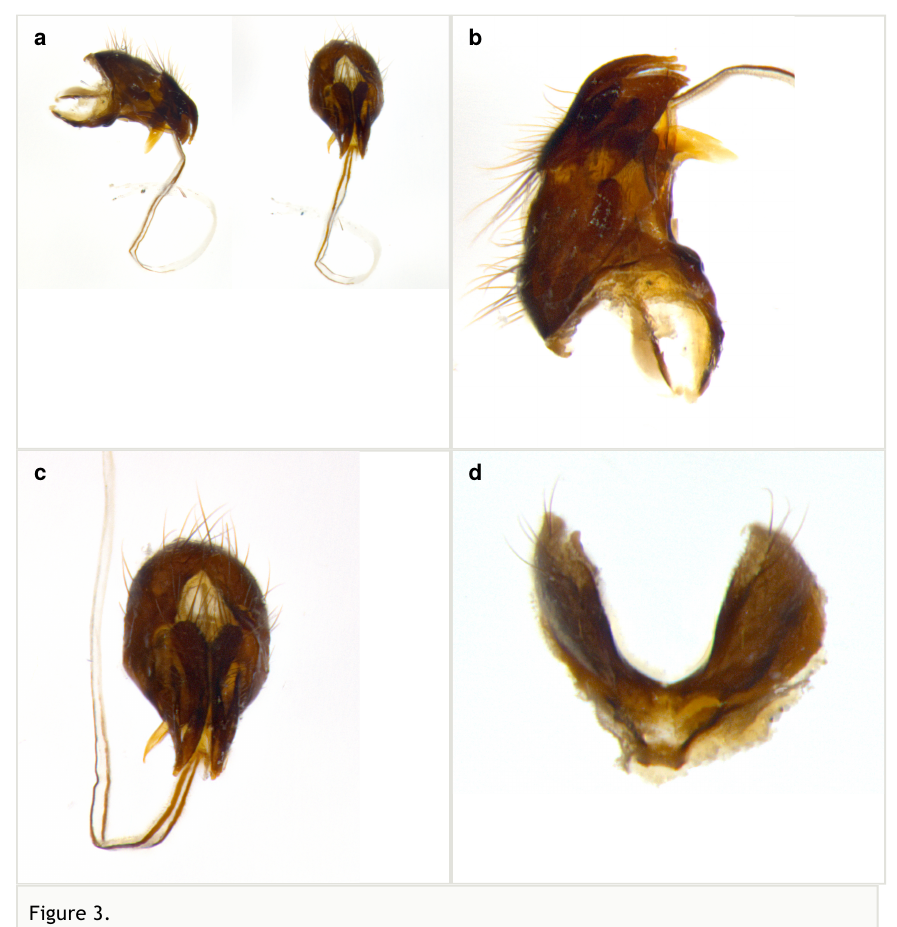
Figure 3. Terminalia of Voria erasmocoronadoi sp. n. Male paratype, voucher code n. DHJPAR0040781 a : terminalia in lateral and posterior views, showing the relative length of the ribbon- like distiphallus b : terminalia in lateral view c : terminalia in posterior view d : sternite 5 in ventral